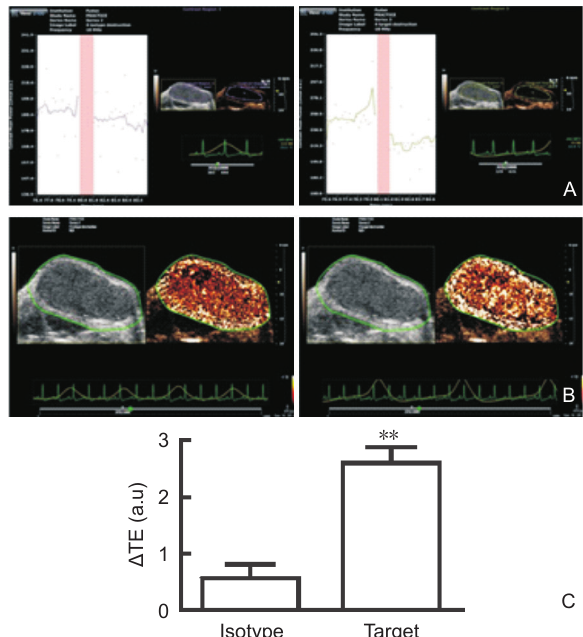
Figure 8 Isotype and endoglin-targeted ultrasound molecular imaging of a nude mouse with subcutaneous HB. (A) Intensity graph for the traced regions of interest prior to and after the destruction pulse (pink region). The region on the left of the column is prior to destruction, and on the right of it is after destruction. The change in intensity following the destruction pulse is an index of the amount of specific binding. The linearized signal prior to the destruction pulse represents bound and circulating microbubbles (MB) and tissue signal. The linearized signal after the destruction pulse corresponds to the MB that were still in circulation and to any residual tissue-echoes, and does not represent the binding process. The ΔTE was computed by subtracting the mean intensity detected after the destructive pulse from that prior to the destructive pulse; (B) Parametric imaging. The scale bar of ΔTE is on the right corner of the map; (C) ΔTE of isotype and endoglin-targeted MB. ΔTE=TEfd - TEpd. n =4; ** P < 0.001. TE, targeted enhancement; ΔTE, differential TE; fd, following destruction; pd, prior to destruction; MB, microbubbles. (Reprinted with permission from reference [30])